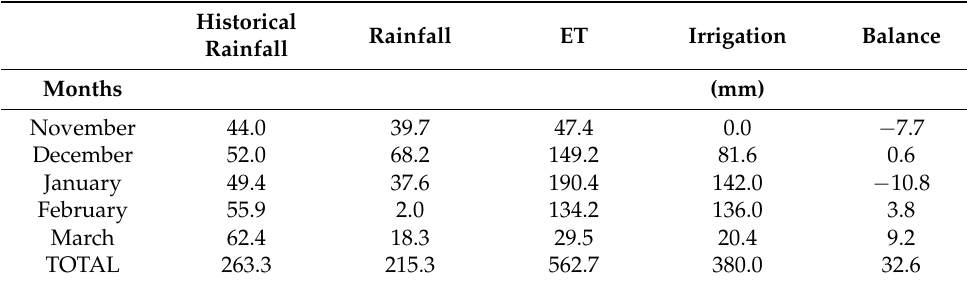
March TOTAL 263.3 32.6 The plot was irrigated through a subsurface drip irrigation (SDI) system. Lateral